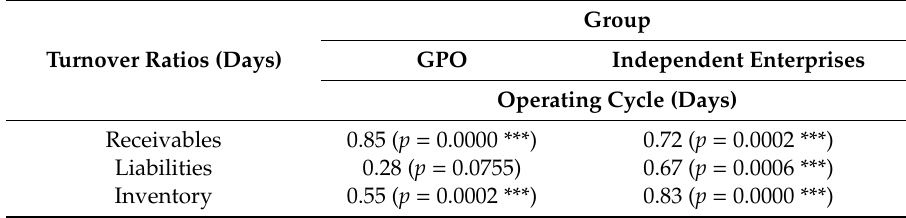
Table 4. Correlations between operating cycle and receivables, liabilities and inventory turnover ratios (Spearman’s rank coe ffi cient of correlation with result of significance